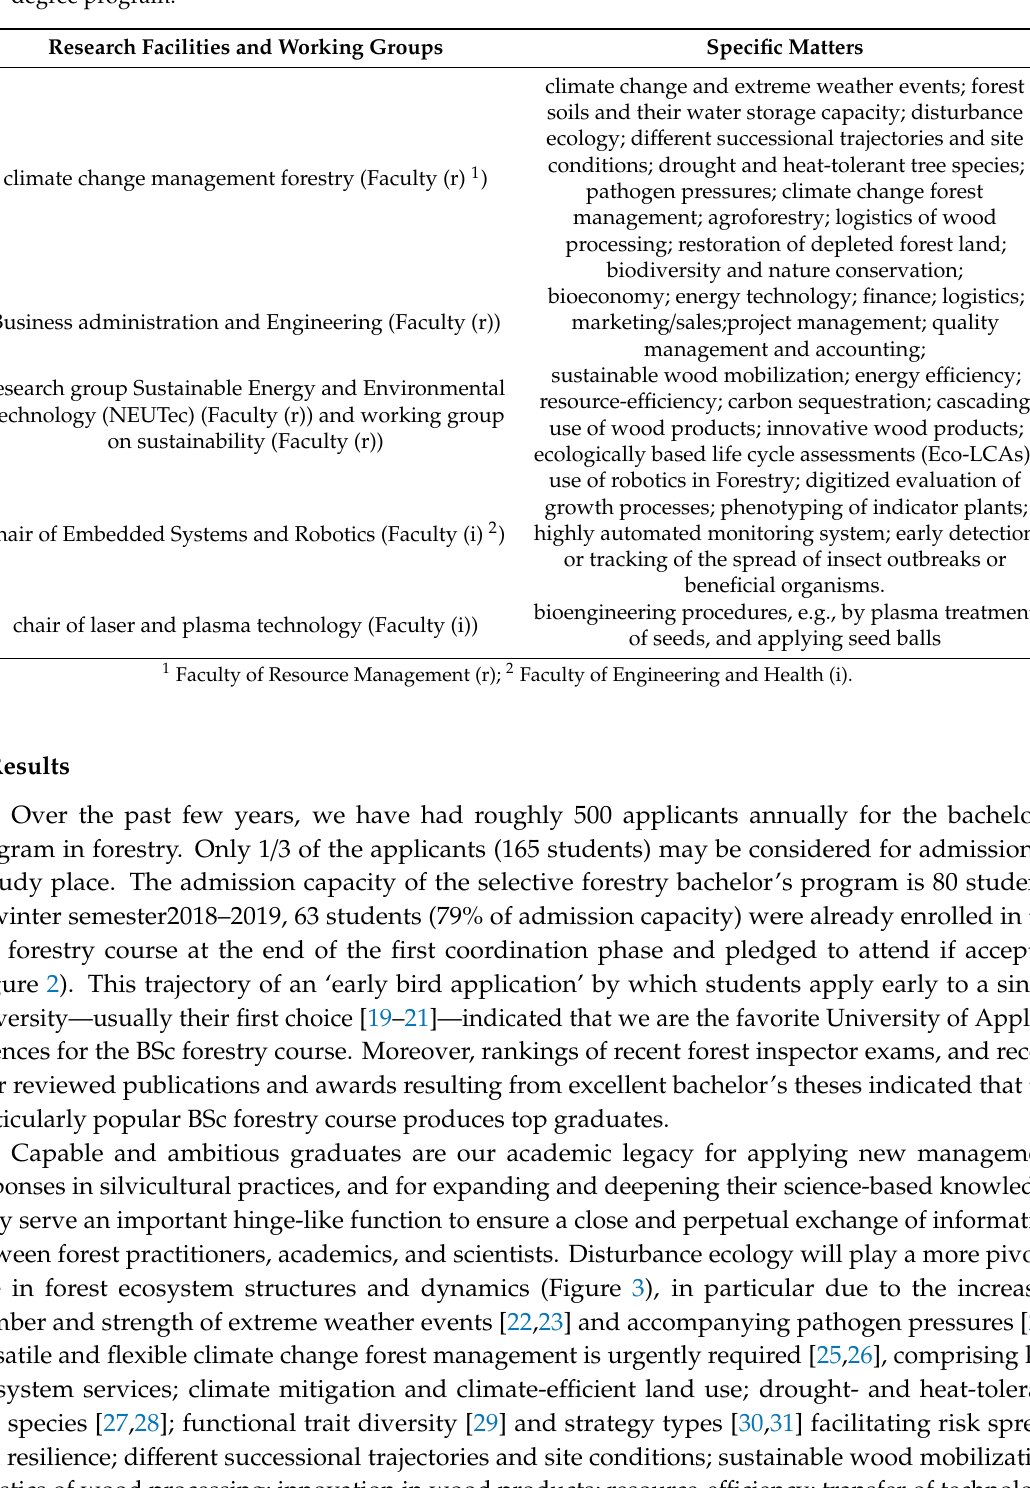
Table 1. Facility-related matters of natural disturbances under climate change to be reflected in the curricula and teaching programs of the pioneering, interdisciplinary Master of Forestry (MF) degree